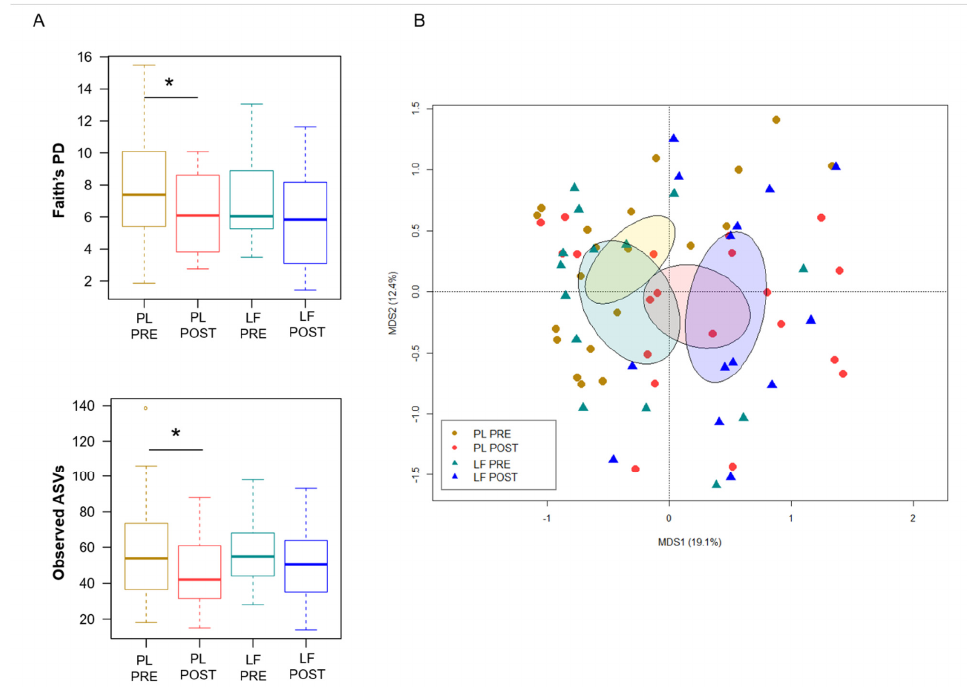
Figure 2. Gut microbiota diversity in pediatric patients with hematological malignancies receiving lactoferrin or placebo during induction chemotherapy. ( A ) Boxplots showing the distribution of alpha diversity, estimated with Faith’s phylogenetic diversity (Faith’s PD) and the number of observed ASVs, before (PRE) and after (POST) placebo (PL) or lactoferrin (LF) supplementation during induction chemotherapy (Wilcoxon test, * for p ≤ 0.05). ( B ) PCoA based on Bray–Curtis dissimilarities between the gut microbiota profiles of study groups. Ellipses include 95% confidence area based on the standard error of the weighted average of sample coordinates. A significant segregation among groups was found (permutation test with pseudo-F ratio, p = 0.005).